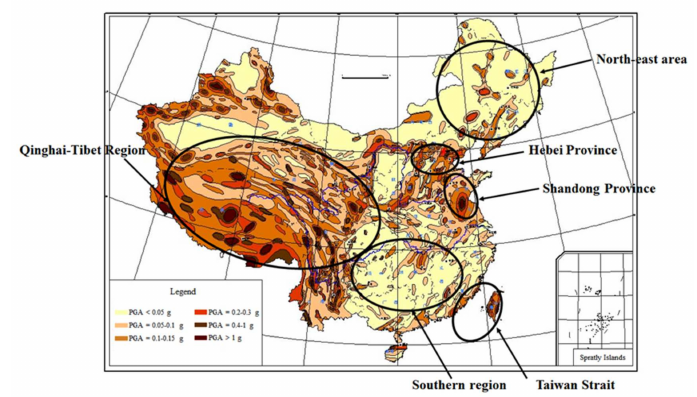
Figure A5. China peak ground acceleration map